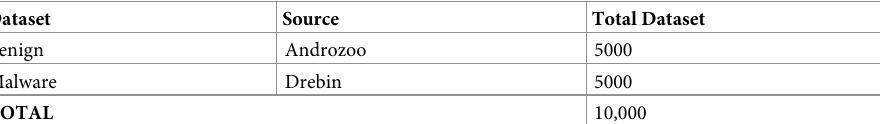
Table 3. Dataset summary.